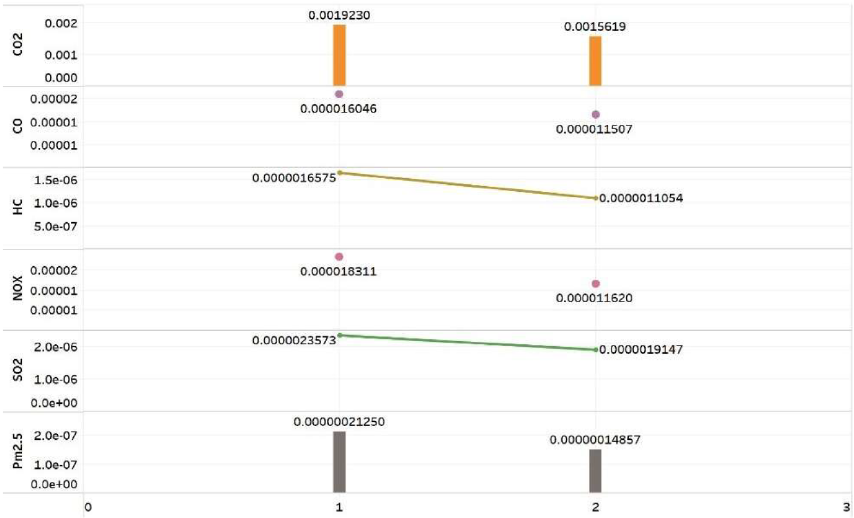
Figure 9. Average unit turnover emissions of each route before and after